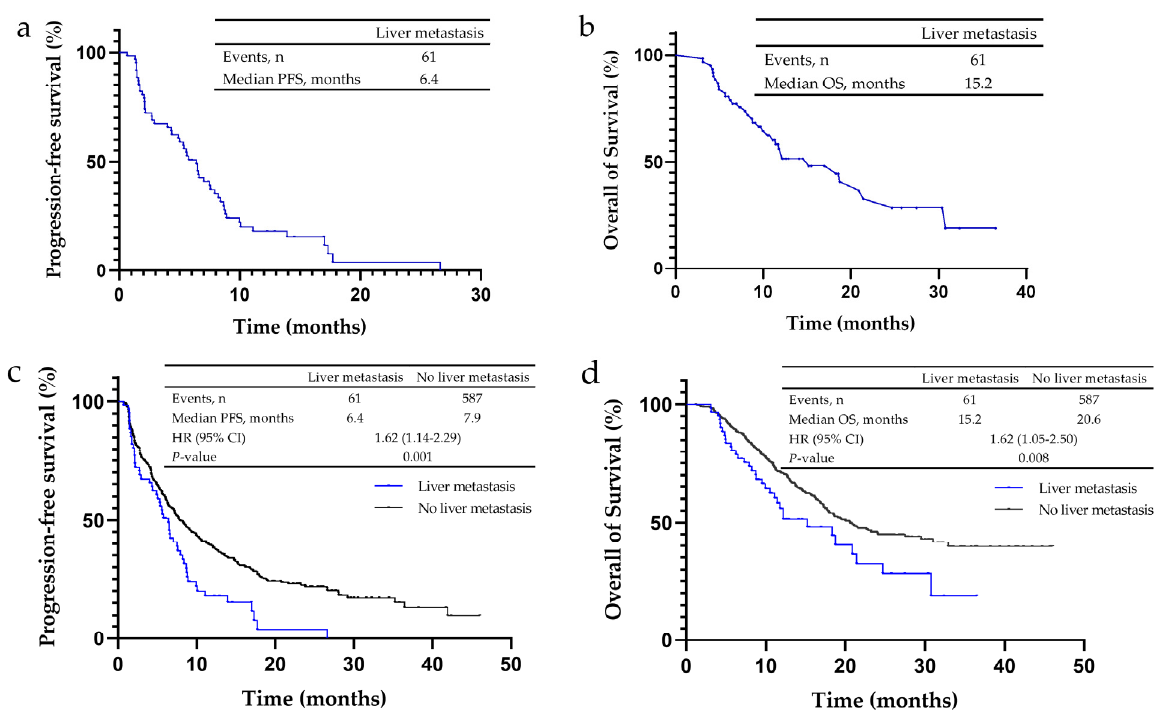
Figure 1. Kaplan–Meier analysis for progression-free survival (PFS) and overall survival (OS) in non-small cell lung cancer (NSCLC) patients treated with PD-1/PD-L1 inhibitors. ( a ) The median PFS of NSCLC patients with liver metastases was 6.4 months. ( b ) The median OS of NSCLC patients with liver metastases was 15.2 months. ( c ) The median PFS of NSCLC patients without liver metastases was 7.9 months, and that of patients with liver metastases was 6.4 months. ( d ) The median OS of NSCLC patients without liver metastases was 20.6 months, and that of patients with liver metastases was 15.2